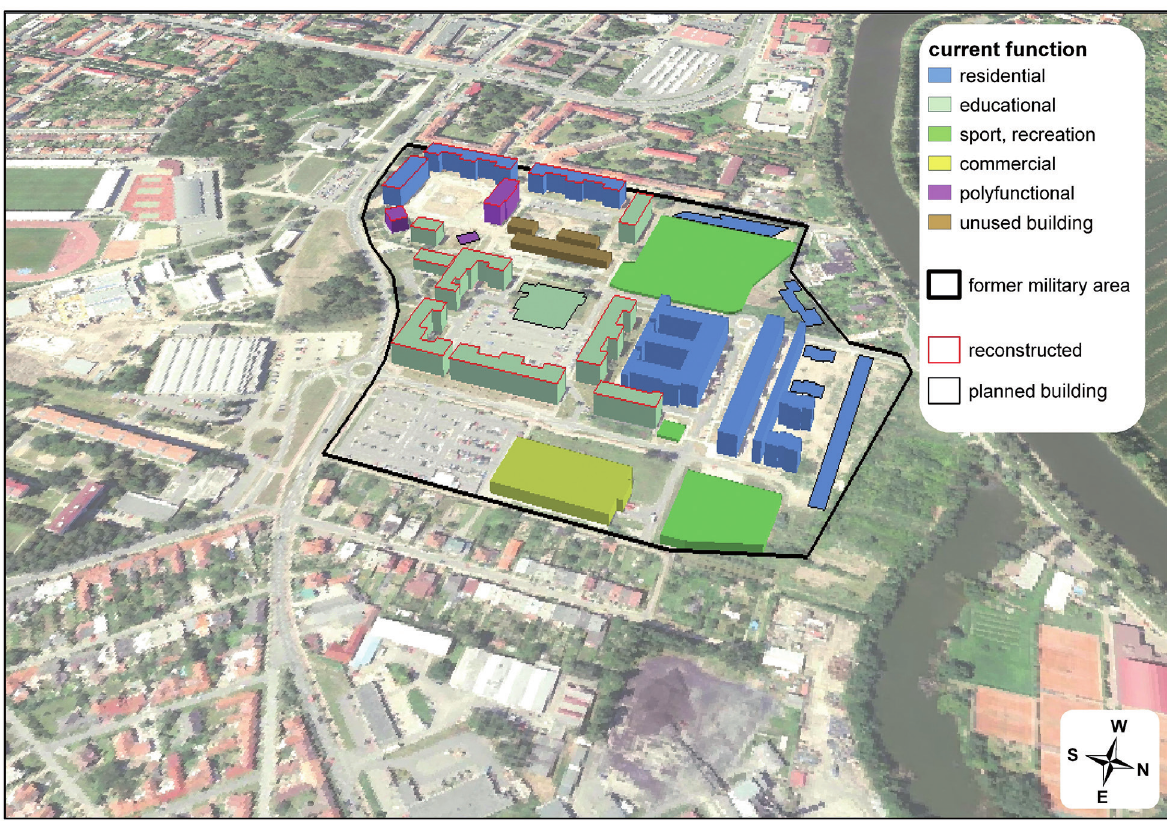
Fig. 4. Functional use of the former barracks in Uherské Hradiště Source: orthophoto by Geoportal čÚZK (2012); authors’ own